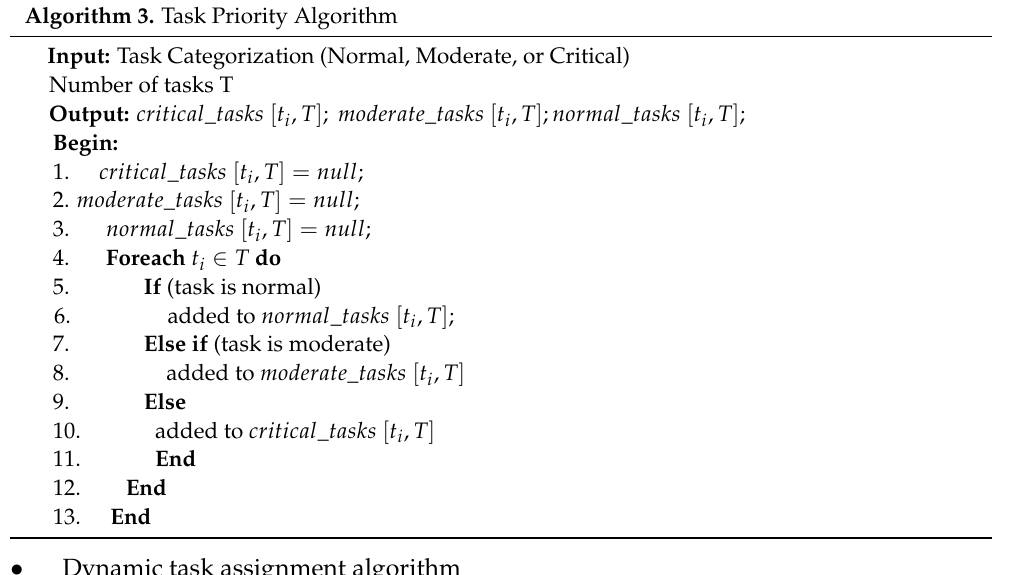
Dynamic task assignment algorithm